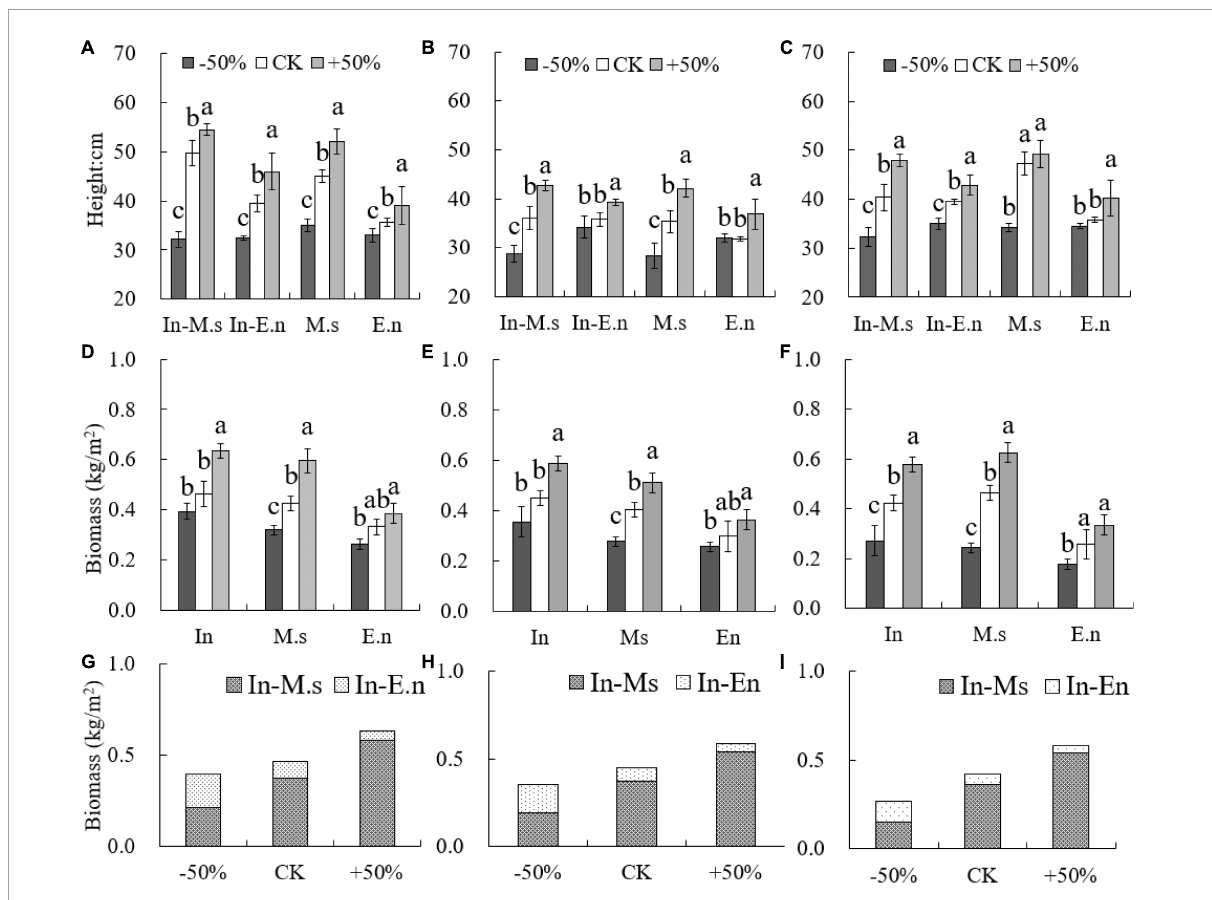
FIGURE8 Differences in height and productivity under different water conditions ( A,D,G : 2015; B,E,H : 2016; C,F,I : 2017). Different lowercase letters show significant differences under different water levels ( P <